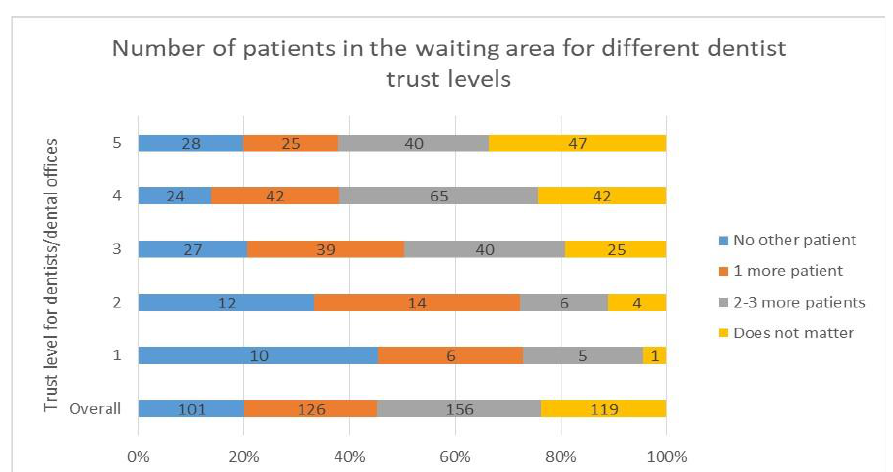
Figure 4 Respondents’ preferences for the number of patients in the dental office waiting area. A stratification based on the respondents’ trust rating for dental offices is also